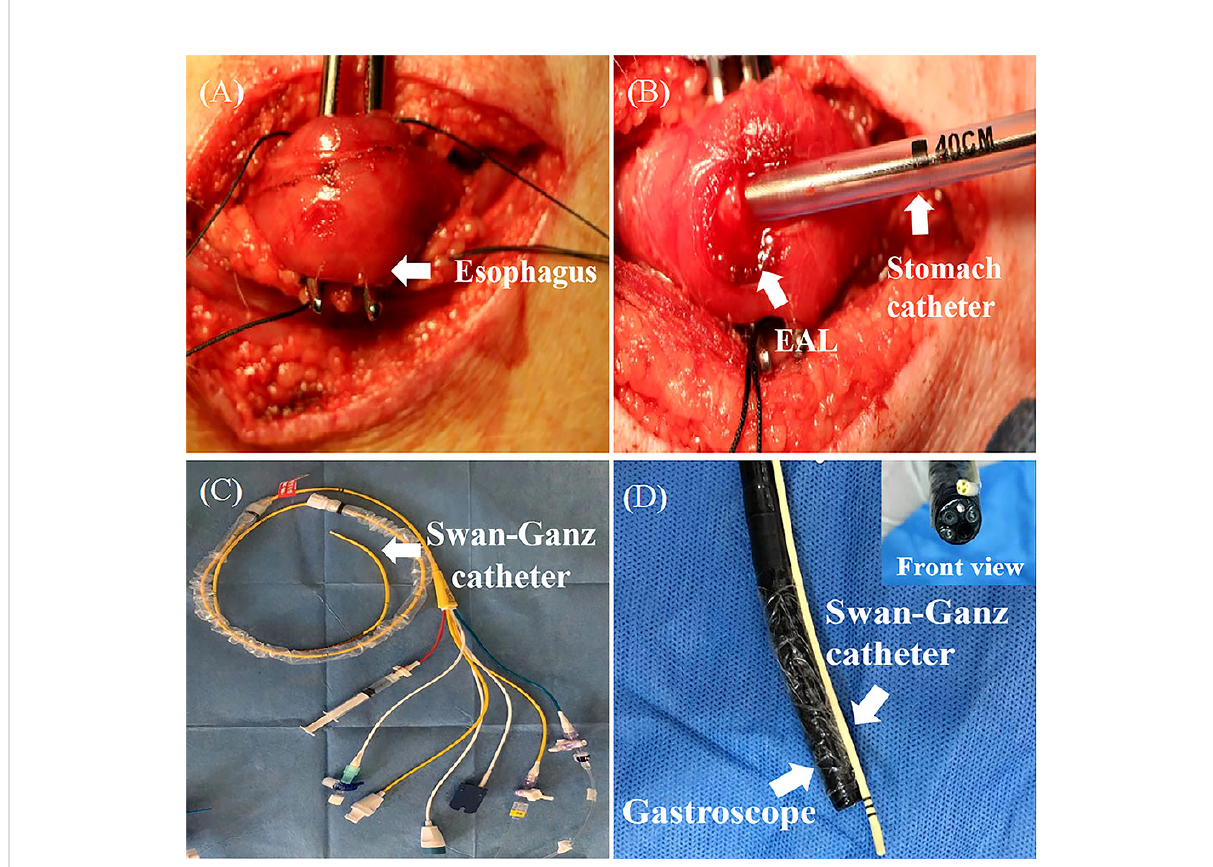
FIGURE 2 The construction of EAL model. (A) , The isolation and exposure of esophagus in pig via left neck incision. (B) , An arti fi cial leakage and a stomach tube (8 mm caliber) inserted in the neck esophagus. Successful extraction of gastric juice via the stomach tube indicated appropriate catheter depth. The catheter was inserted into the digestive tract to an average depth of 35 cm. (C, D) , Swan-Ganz catheter fi xed at the front end of the gastroscope with its terminal end moved forward by about 1 cm. EAL, esophageal anastomotic